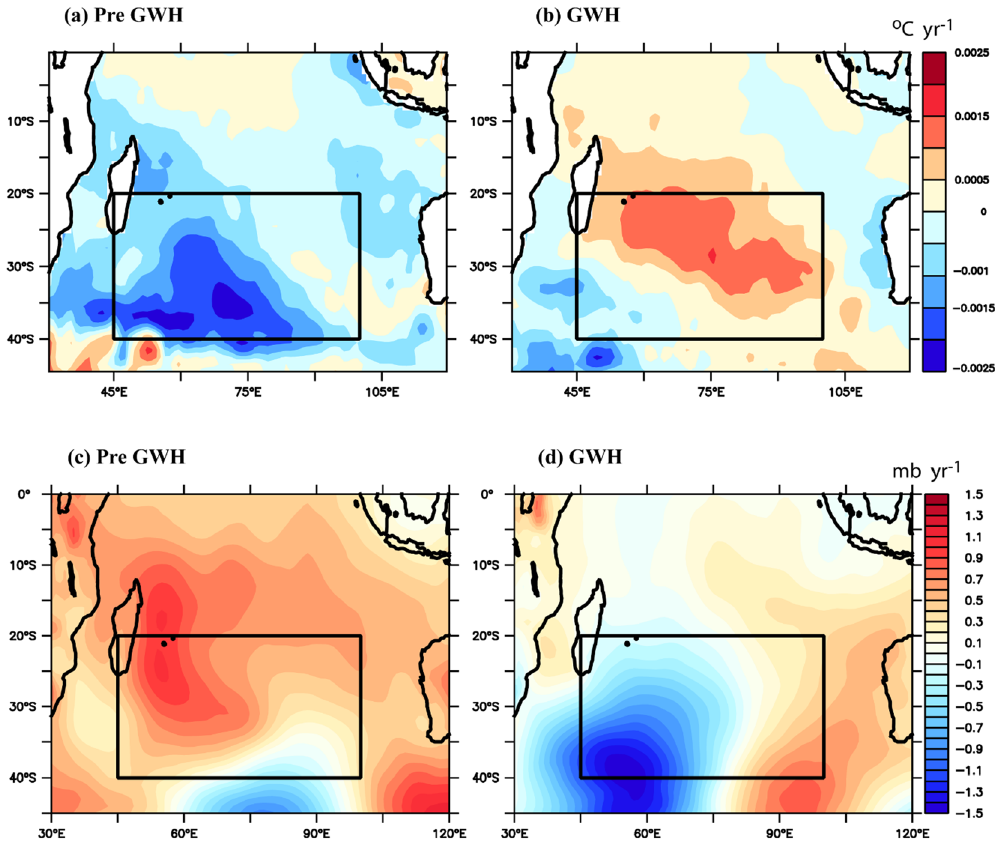
Figure 4. Spatial pattern of trend of ( a ) SST during preGWH, ( b ) SST during GWH, ( c ) MSLP during preGWH, ( d ) MSLP during